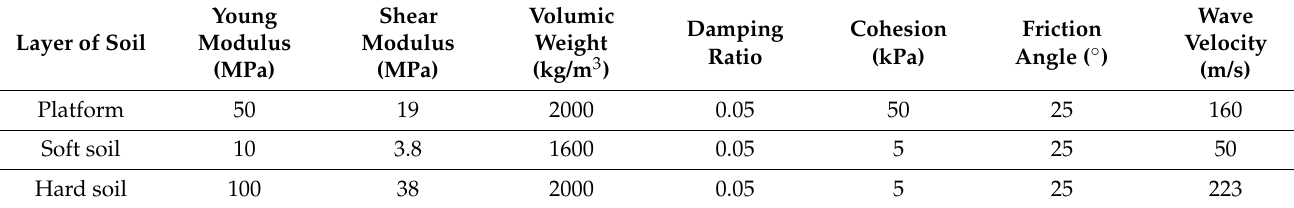
Table 4. Material properties considered in the